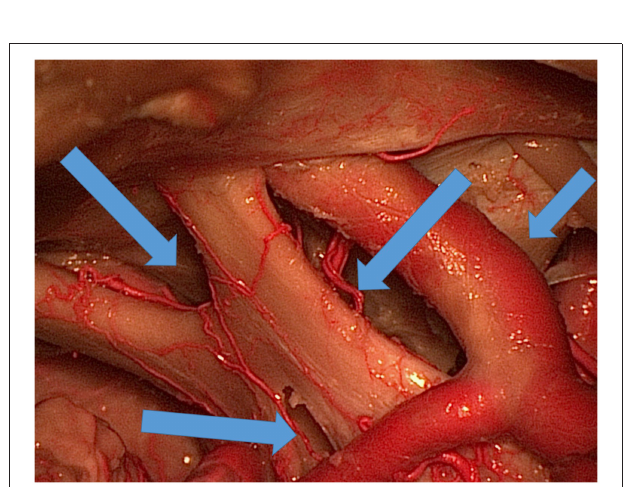
FIGURE 3 | Various ways (blue arrows) of exposing the area under and around the optic chiasm and through the lamina terminalis to the third ventricle.